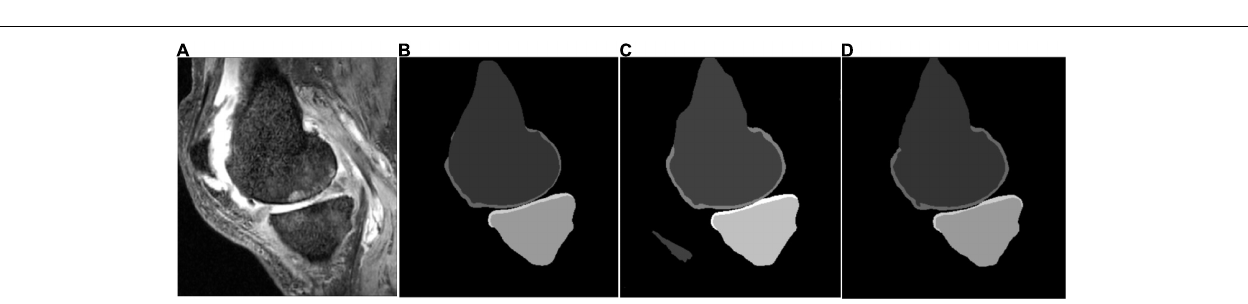
FIGURE 3 | Segmentation results based on different schemes: (A) sagittal slice of the image; (B) ground truth; (C) nnU-Net two-dimensional (2D); and (D) proposed method.